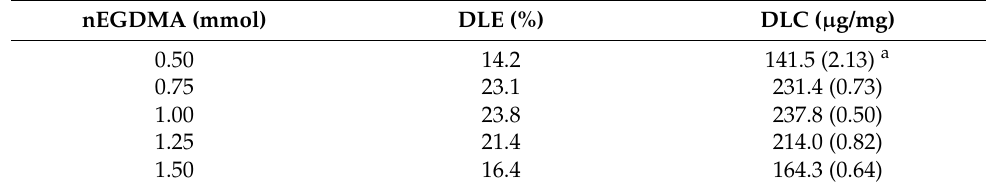
Table 3. Effects of the crosslinking agent contents on drug loading content and efficiency for MOF@P.